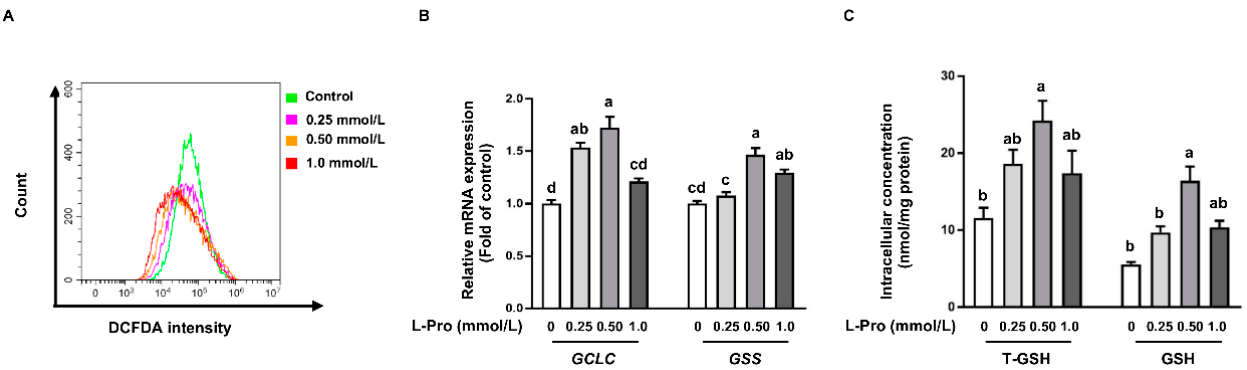
Figure 4. Effect of proline on ROS level and GSH concentration in pTr2 cells. ( A ) DCFH-DA positive populations were determined by flow cytometry analysis in a time course. ( B ) mRNA levels for GCLC and GSS . ( C ) Intracellular T-GSH and GSH. Data are expressed as the percentage of control group. Values are means ± SEMs, n = 3. Means at a time point without a common letter differ, p < 0.05. DCFH-DA, 2 ′ ,7 ′ -Dichlorofluorescein diacetate; pTr2, porcine trophectoderm cells 2; GCLC, catalytic subunit of glutamate–cysteine ligase; GCLM, glutamate–cysteine ligase modifier subunit; GSH, glutathione; GSS, glutathione synthetase.